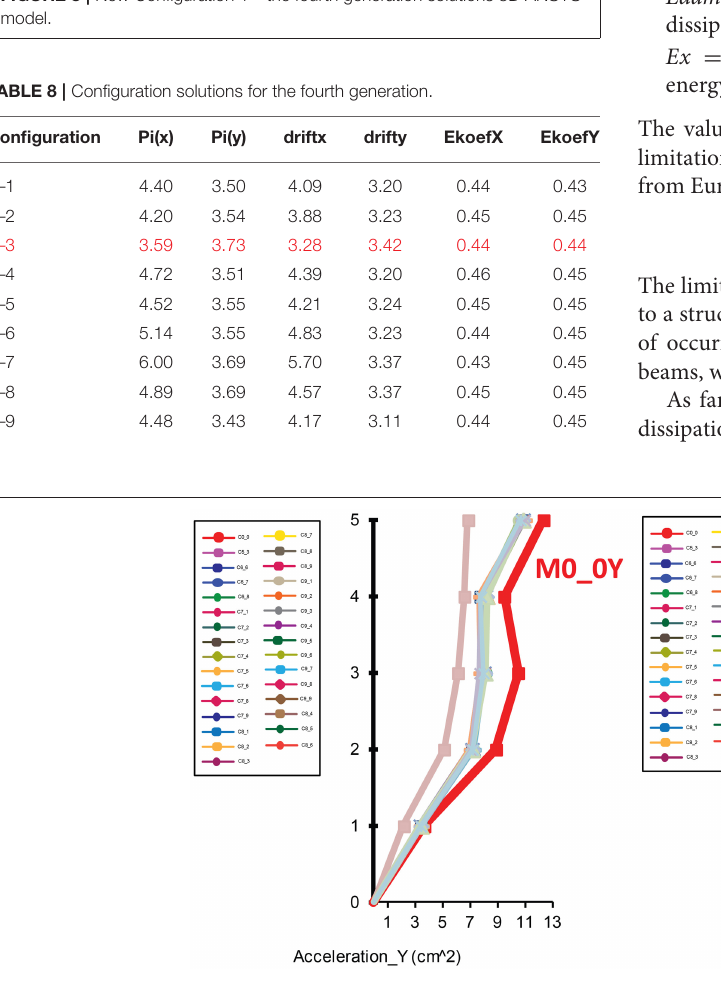
FIGURE 9 | Acceleration in X and Y direction for all thirty optimal solutions compared with a structure without dampers (M0_0X; M0_0Y).